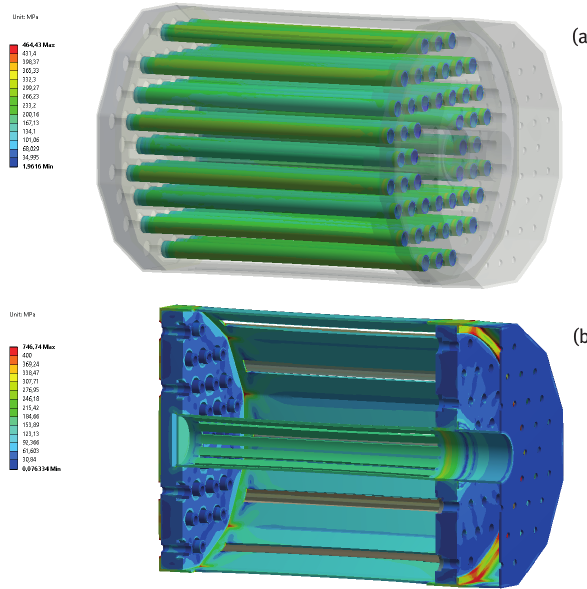
Figure 29: Distribution of operating von Mises stress of the mSOFC stack with supporting structure [MPa]: (a) fuel cell view, (b) structure